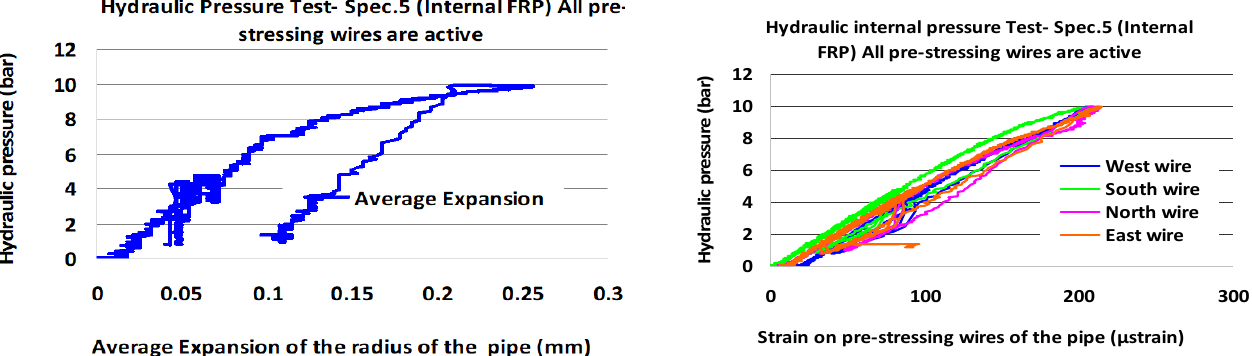
Figure 16. Measured response for Specimen 5 with fully active prestressing and an internal FRP jacket: ( Left ) average radial expansion; ( Right ) radial strains of the prestressing wires (1 bar = 0.1 N/mm 2 ).